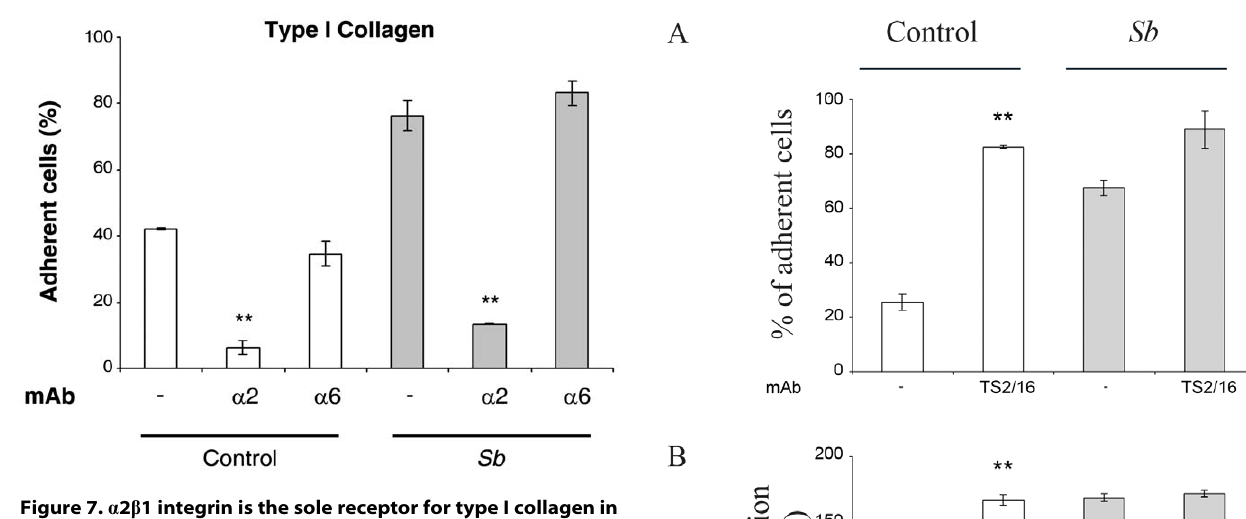
Figure 7. a 2 b 1 integrin is the sole receptor for type I collagen in HCT8/E11 cells. Isolated HCT-8/E11 cells were incubated with or without Sb supernatant in the absence ( 2 ) or presence of either anti- a 2 or - a 6 integrin mAbs. Cells were then seeded on type I collagen (3 m g/ ml). Cell adhesion was evaluated as described in Methods. Data represent the mean 6 SD of 3 separate experiments. ** P , .01.